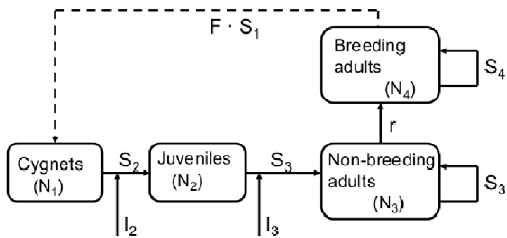
Figure 1. A conceptual description of the population model, indicating how the numbers of cygnets (N 1 ), juveniles (N 2 ), non-breeding adults (N 3 ) and breeding adults (N 4 ) were calculated. F and S refer to fecundity, and survival, respectively, whilst r refers to the recruitment of non-breeding adults into the breeding subpopulation.